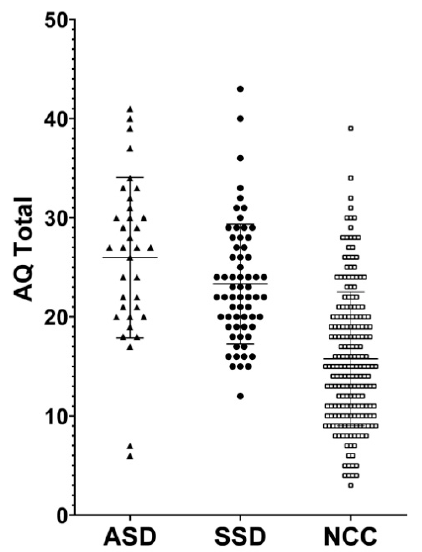
Figure 1. Distribution of AutismSpectrum Quotient (AQ) total scores among individuals with autism spectrum disorder (ASD), schizophrenia spectrum disorders (SSD) and non-clinical controls (NCC).